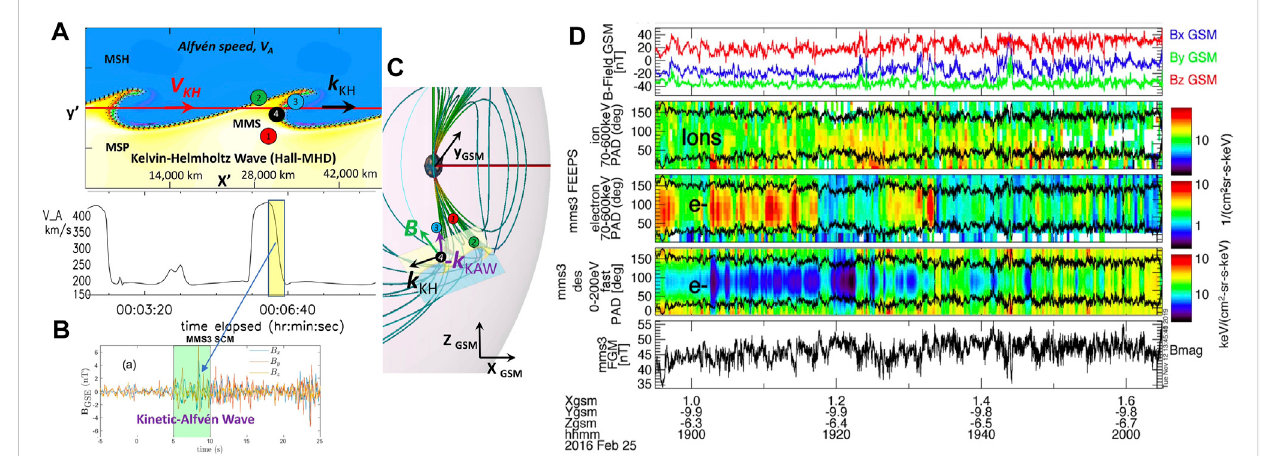
FIGURE 2 Example of MMS observations of KHWs at the vicinity of the southern exterior cusp ( (C) ; Nykyri et al., 2021b). When MMS travels through strong Alfvén speed gradients (A) , kinetic Alfvén waves (KAW) were observed (B) . The KAWs carry energy into the ionosphere and were responsible for partial parallelheatingofcoldelectrons.Thestackplot (D) showsmagnetic fi eld(top),pitch-angledistributionsofenergeticionsandelectrons(secondandthird panels),pitch-angledistributionsoflowenergyelectrons(fourthpanel),andmagnetic fi eldstrength(bottompanel).Thelow-energyelectronsarein theloss cone(outsidetheblack envelope which is thelocal trapping angle),whilethehigh-energy (70 – 600 keV) electronsare trapped. The high-energy ions are less adiabatic and can stream out. The origin of these high-energy particles within KHWs is currently not known but may be related to the previously-formed diamagnetic cavities and/or local acceleration within